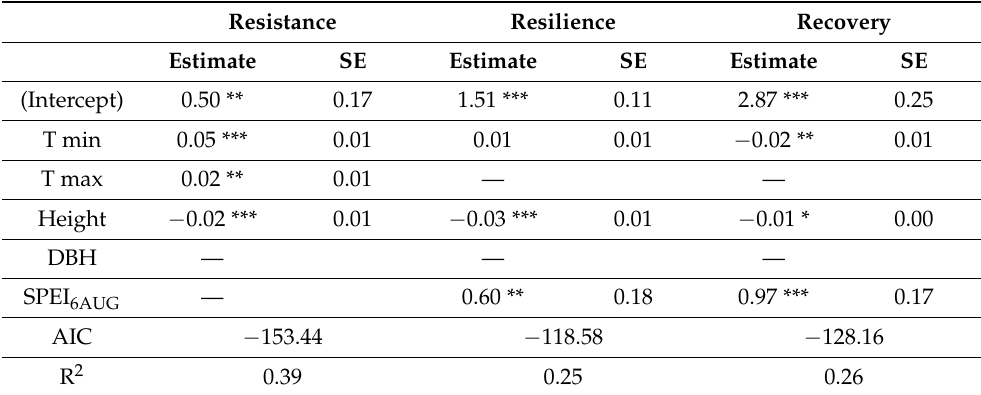
Figure 4. The resilience components for the five provenances grown in the four common gardens. Table 4. Models selected for each index. Values for each predictor represent the estimates and the standard errors